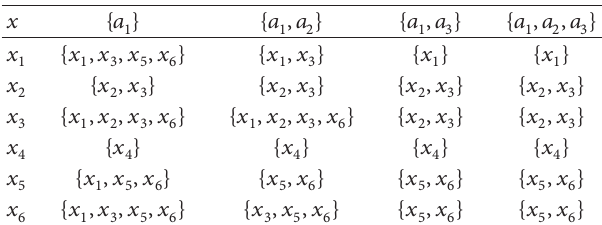
Table 6: The neighborhood of objects on different test